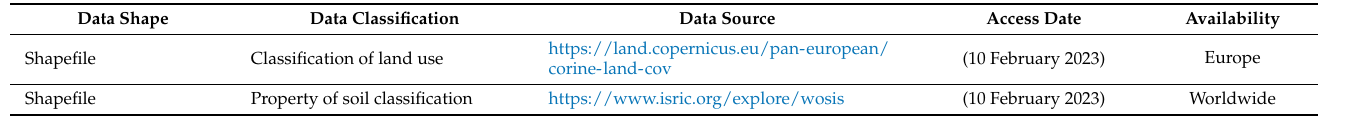
Table 2. Various datasets available for use in modeling